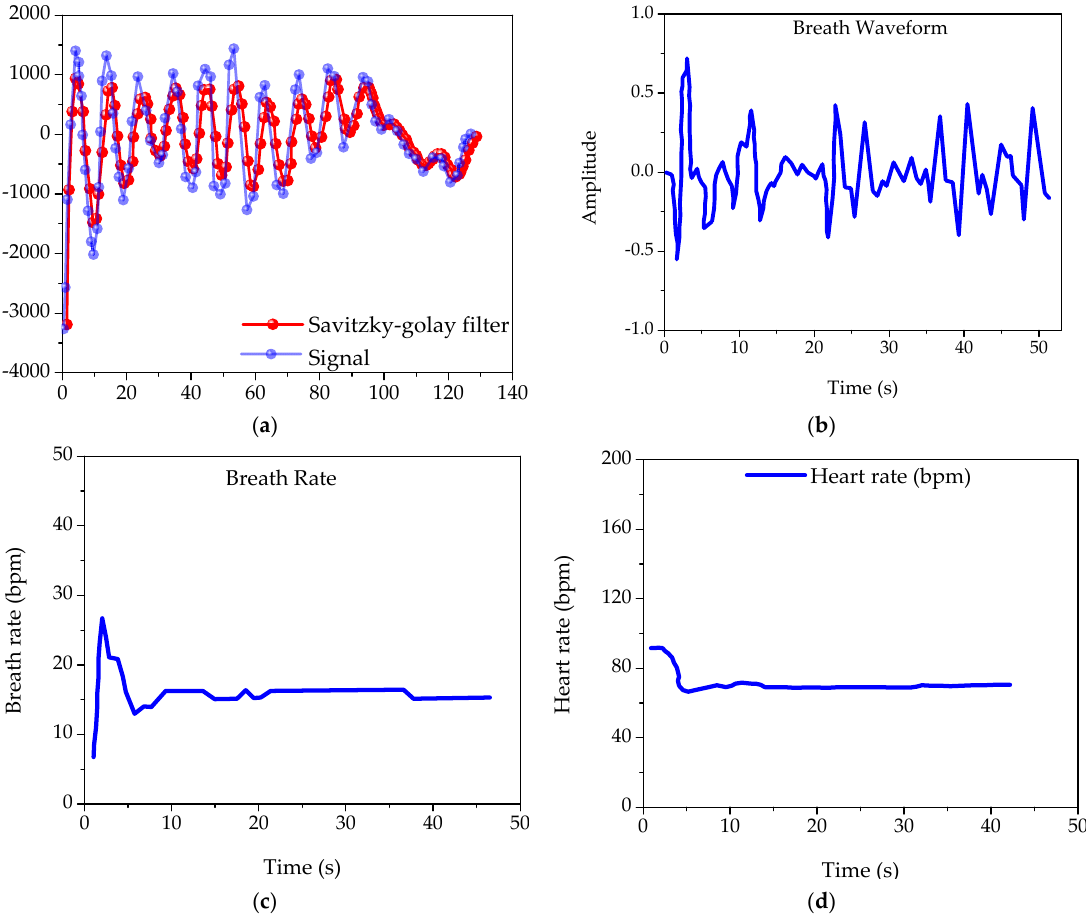
Figure 21. ( a ) Savitzky-Golay filter and signal waveform; ( b ) breath waveform signal; ( c ) breath rate signal waveform; and ( d ) heart rate